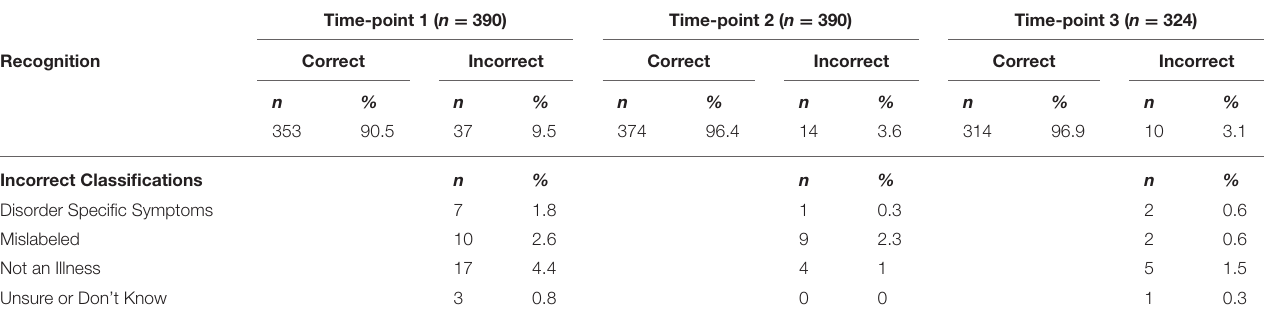
TABLE 2 | Student’s description of Adam’s problem in pre (time-point 1) and post (time-point 2) intervention as well as 3-months (time-point 3) from intervention. Time-point 1 ( n =